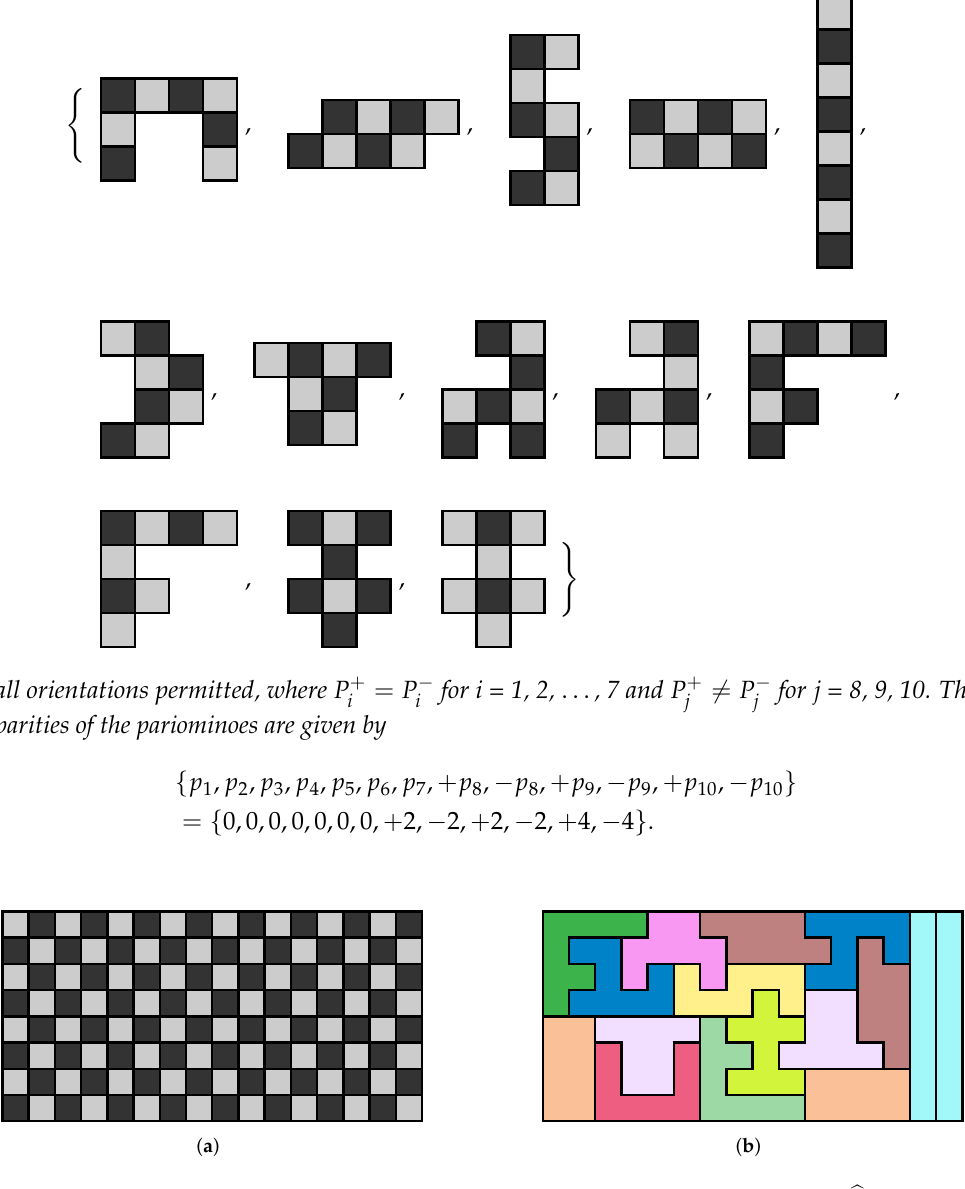
Figure 22. Target region and a tiling solution for Example 10: ( a ) The target region (cid:98) R , a checker- board coloured 8 × 16 rectangle; ( b ) Successful tiling of the target region (cid:98) R using 16 octomi- noes. The optimal solution corresponds to the first pariomino tiling subproblem in Table 6 with ( a + ) = ( 0,2,1,1,1,0 ) . The pariomino P + , a − , a + , a − , a + , a − 8 8 9 9 10 10 from P − , which is coloured light 9